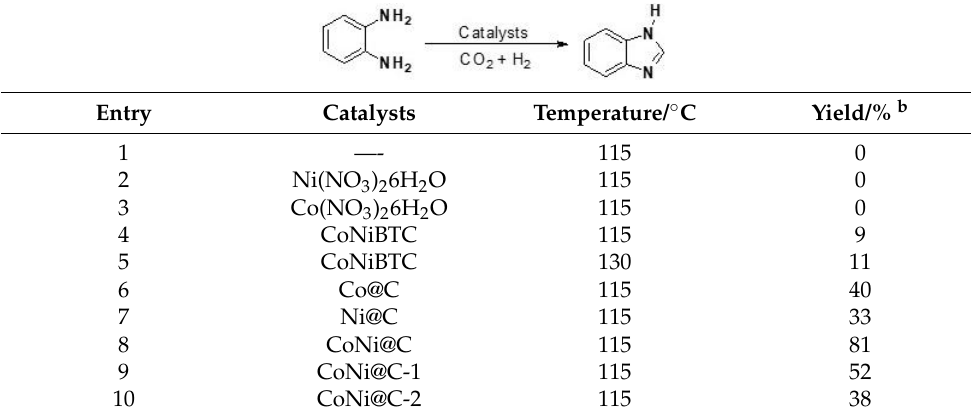
Table 1. Synthesis of benzimidazole with different catalysts a.